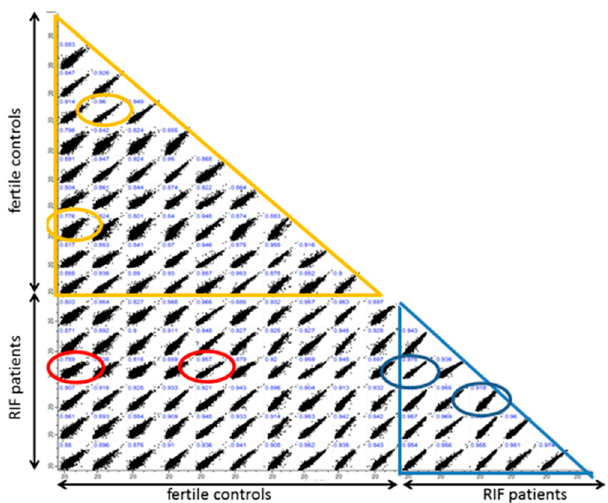
Figure 2. Intensity correlation (log 2 intensities are shown) of protein of endometrial tissue of RIF patients ( n = 6) and PF ( n = 10). Comparison within the RIF group is marked by a blue triangle and within the PF group by an orange triangle. Circles represent the highest and lowest correlation coefficient of the respective group comparison. The red circles highlight the highest and lowest correlation coefficient between RIF and PF.